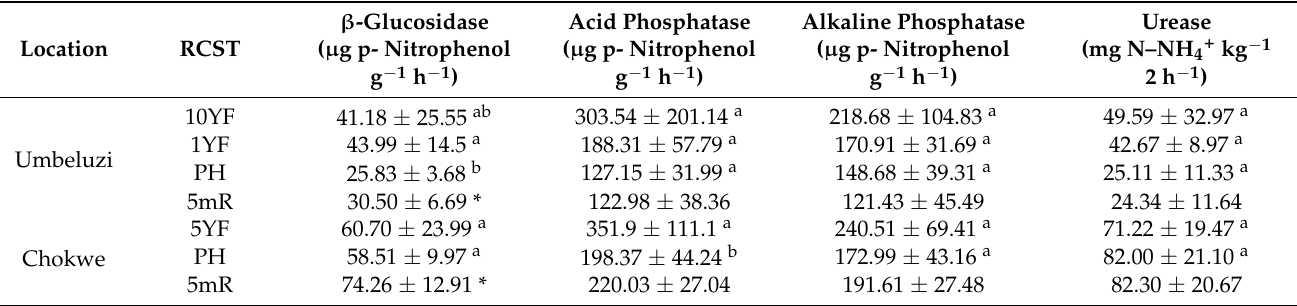
Table 3. Enzyme activities in